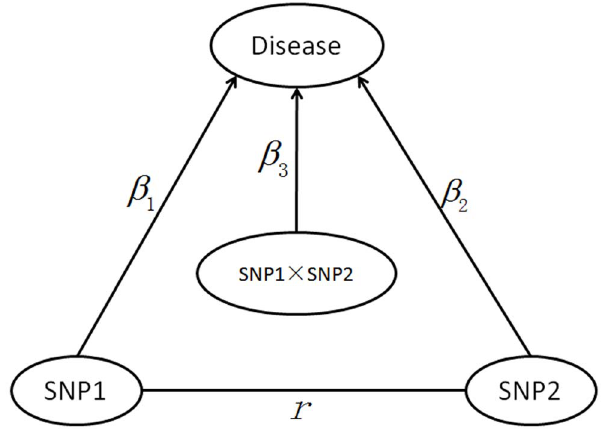
Figure 1. A causal graph framework for two SNPs affected the disease. b 1 and b 2 represents main effects, b 3 denotes the traditional interaction, the nondirectional arc between SNP1 and SNP2 (correlation r ) indicated that the two variables are associated for reasons other than affecting one